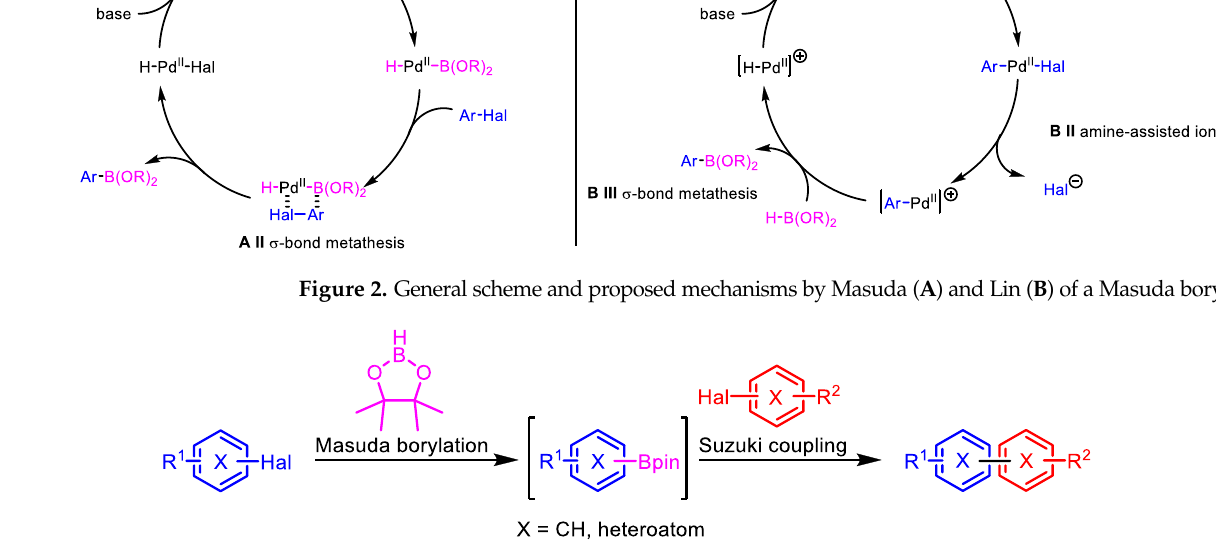
Figure 3. Linkage of Masuda borylation and Suzuki coupling into a one-pot MBSC sequence.